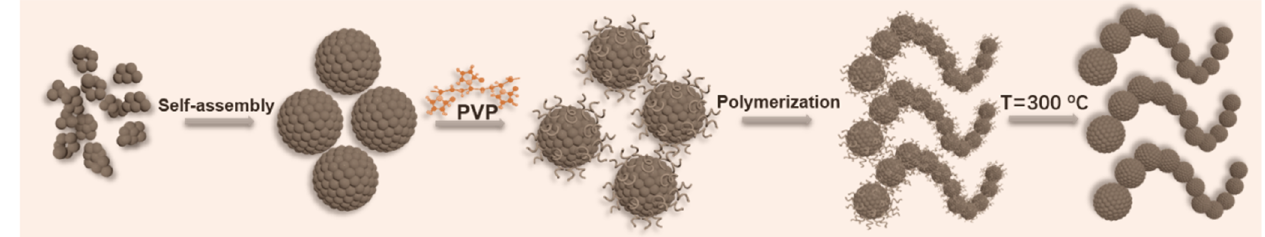
Figure 1. Schematic illustration for the formation procedure of chain-like ferrite.